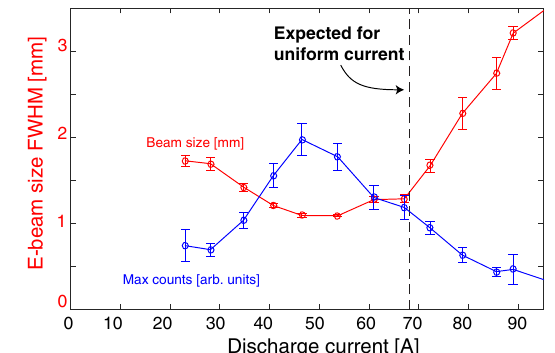
FIG. 3. Electron beam size (red circles) and peak signal level (blue circles) on the phosphor screen in a current timing scan at 8 × 10 16 cm − 3 He atomic density. The dashed black line displays the current at which one would expect focusing in case of uniform radial current